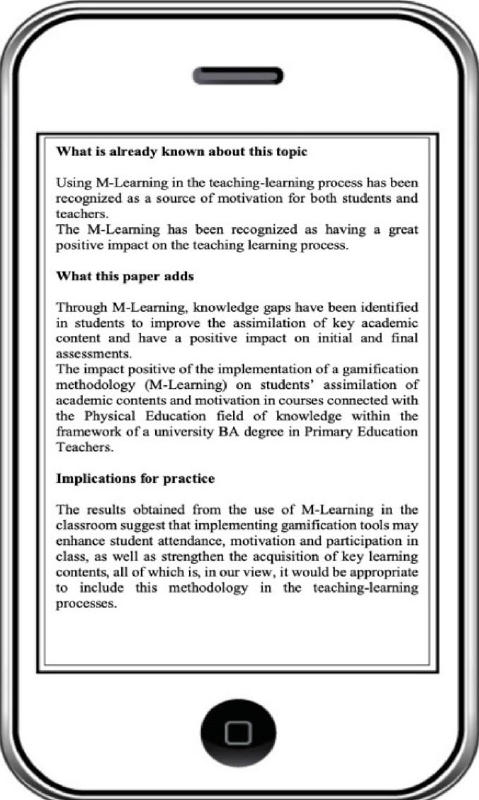
Figure 5. Assessment of students in the single checkboxes of the satisfaction